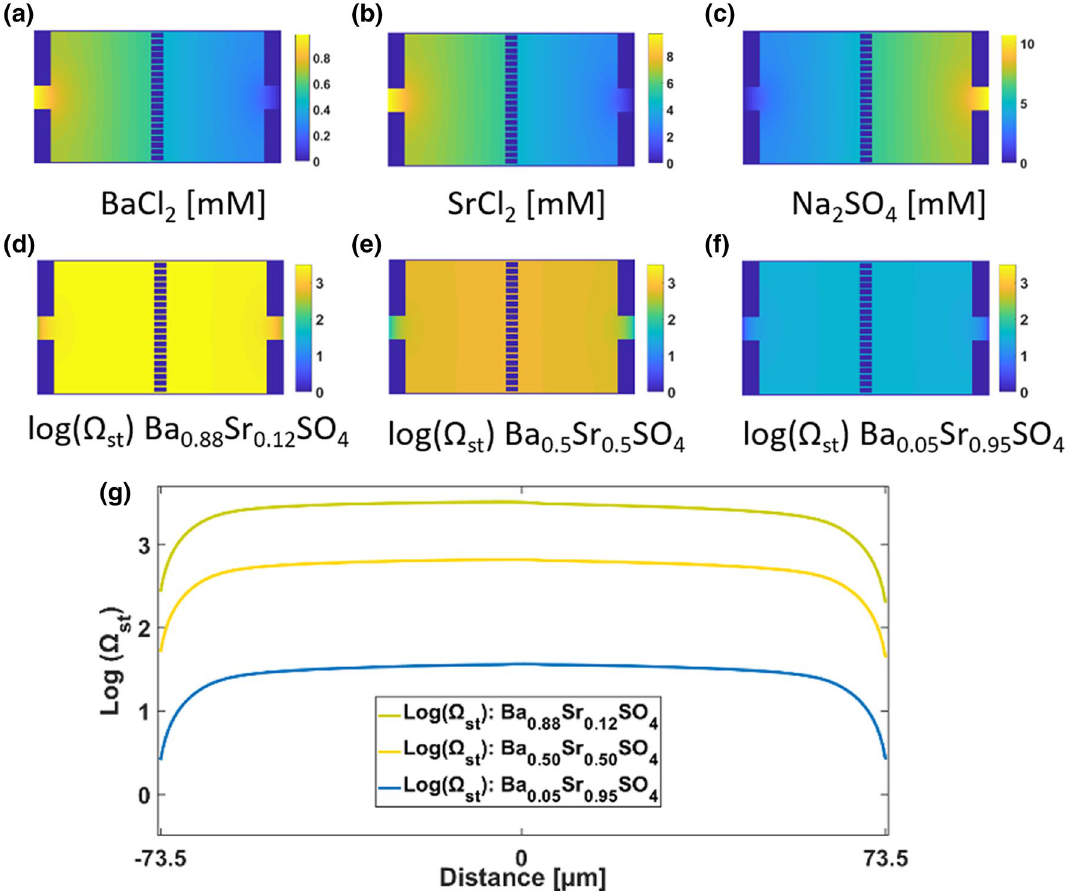
Figure 6. Map of ( a ) BaCl 2 , ( b ) SrCl 2 and ( c ) Na 2 SO 4 concentrations distributions in the growth chamber and associated stoichiometric supersaturation ratio with respect to ( d ) Ba 0.88 Sr 0.12 SO 4 , ( e ) Ba 0.5 Sr 0.5 SO 4 and ( f ) Ba 0.05 Sr 0.95 SO 4 with their respective plots of stoichiometric saturation ratio profiles along y = 0 in ( g ) for a better